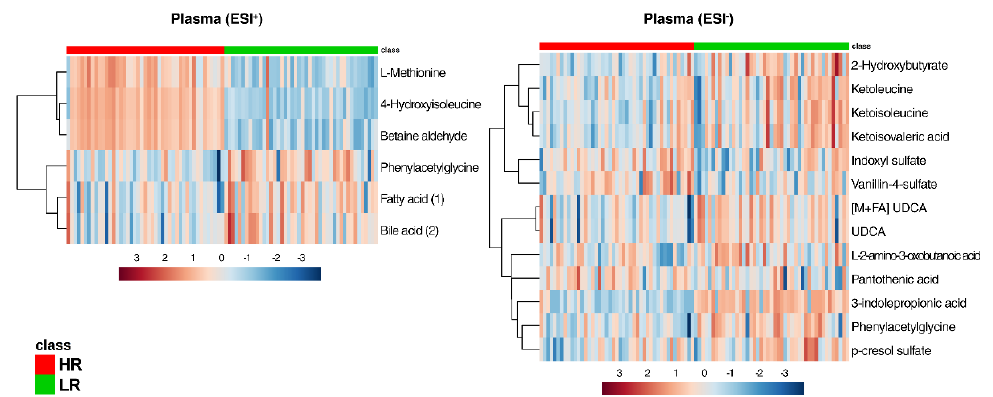
Figure 5. Heat maps of metabolites discriminating ( p < 0.05) between the HR (red class) and the LR (green class) diet in plasma of Göttingen Minipigs in both positive and negative ionization mode (electrospray ionization (ESI+, ESI − )). Abbreviations: UDCA, Ursodeoxycholic acid; FA, formic acid adduct.